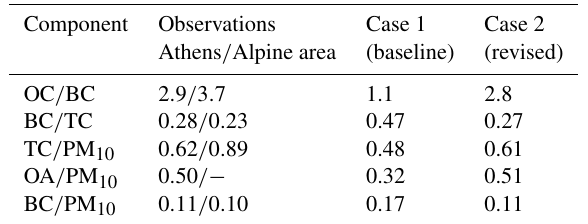
Table 5. Averaged daily means of selected aerosol mass frac- tions against ground measurements at Thissio (Athens) during the RWB smog period (19 December 2013–5 January 2014) and at Swiss Alpine areas (winter 2005; Szidat et al., 2009). Organic aerosol (OA) predictions are divided by 1.6 (Turpin and Lim, 2001) to extract the carbon mass (OC) used for the calculation of the OC / BC